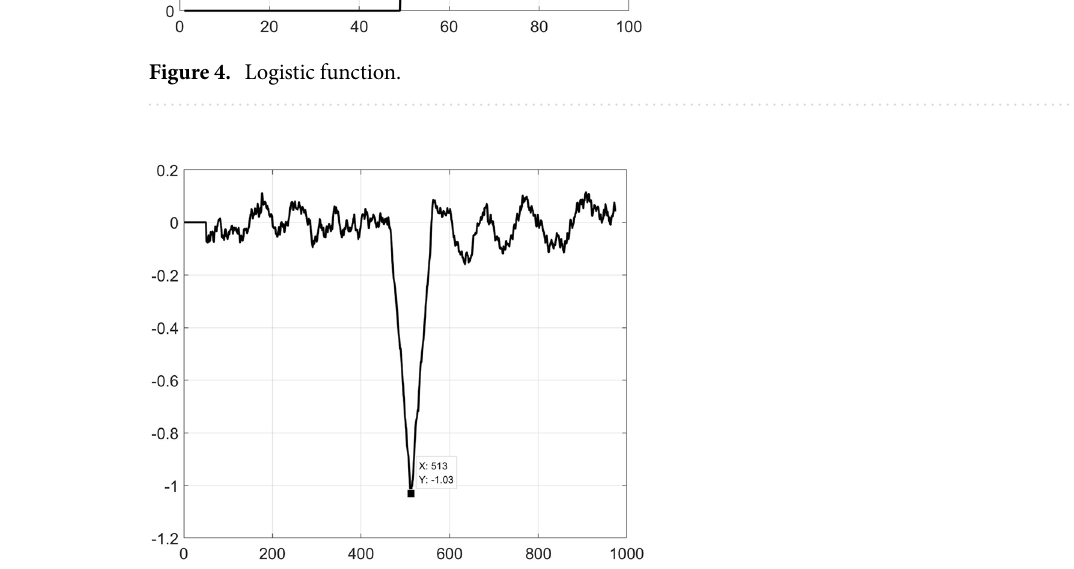
Figure 5. The slope of the mutual correlation curves between the logistic function and signals.